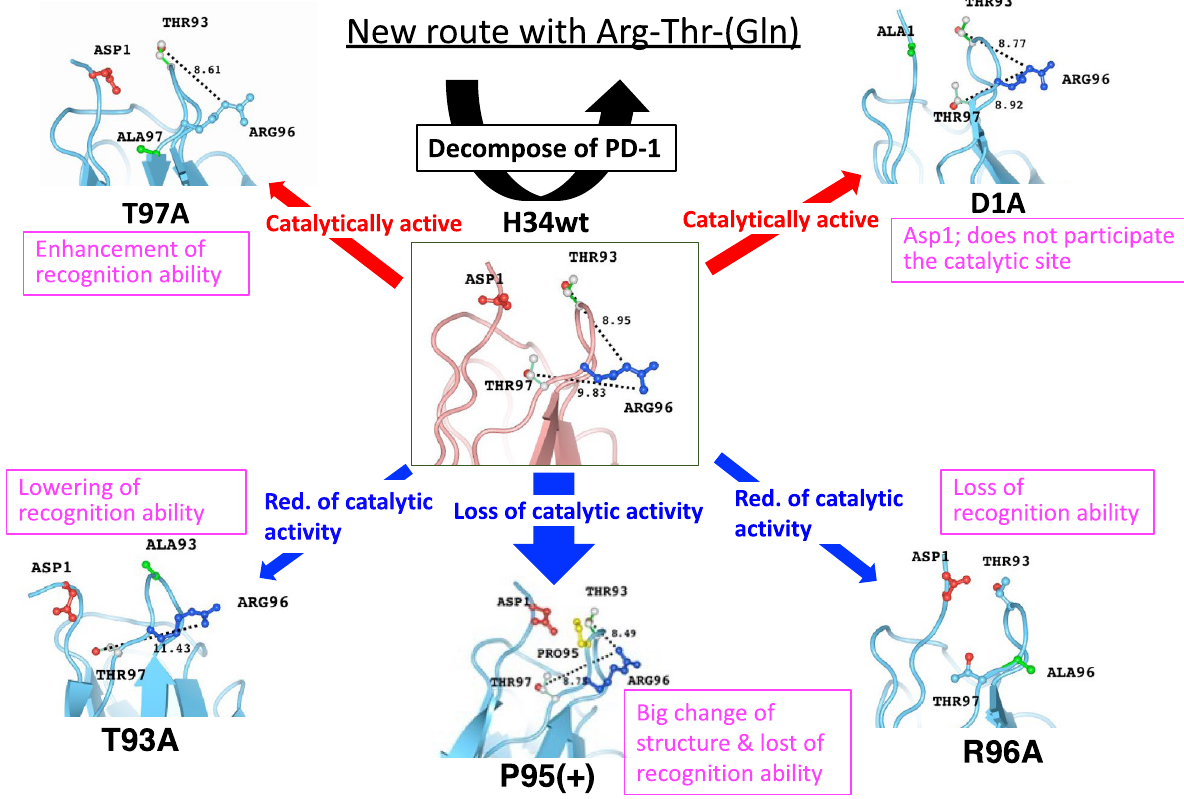
Figure 11. Interrelations of features of H34wt and the mutants. Mutagenesis in this study clarified the amino acid residues constructing the catalytic site, which is composed of Arg96, Thr93, and Gln89, revealing a new catalytic site for the cleavage of PD-1, which is different from the serine protease triad. The figure shows the interrelation among H34wt and the mutants; in addition to structural changes, several crucial changes are detected in terms of chemical and immunological characters. The number indicates the distance between the Arg and Thr residues.